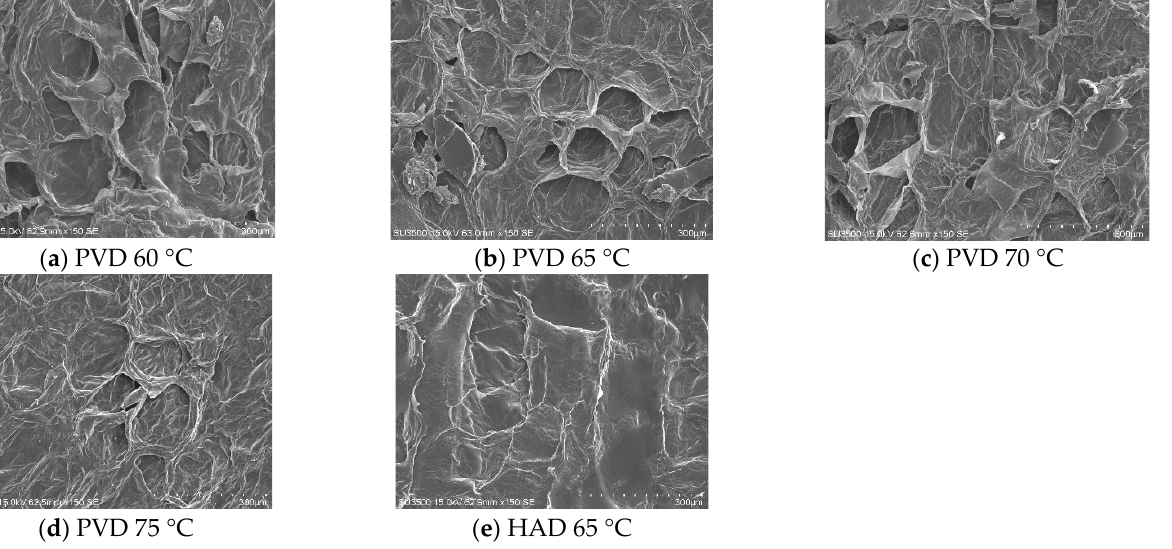
Figure 5. The surface microstructure of dried persimmon slices under different drying conditions. PVD: pulsed vacuum drying (12:4 min). HAD: hot air drying.